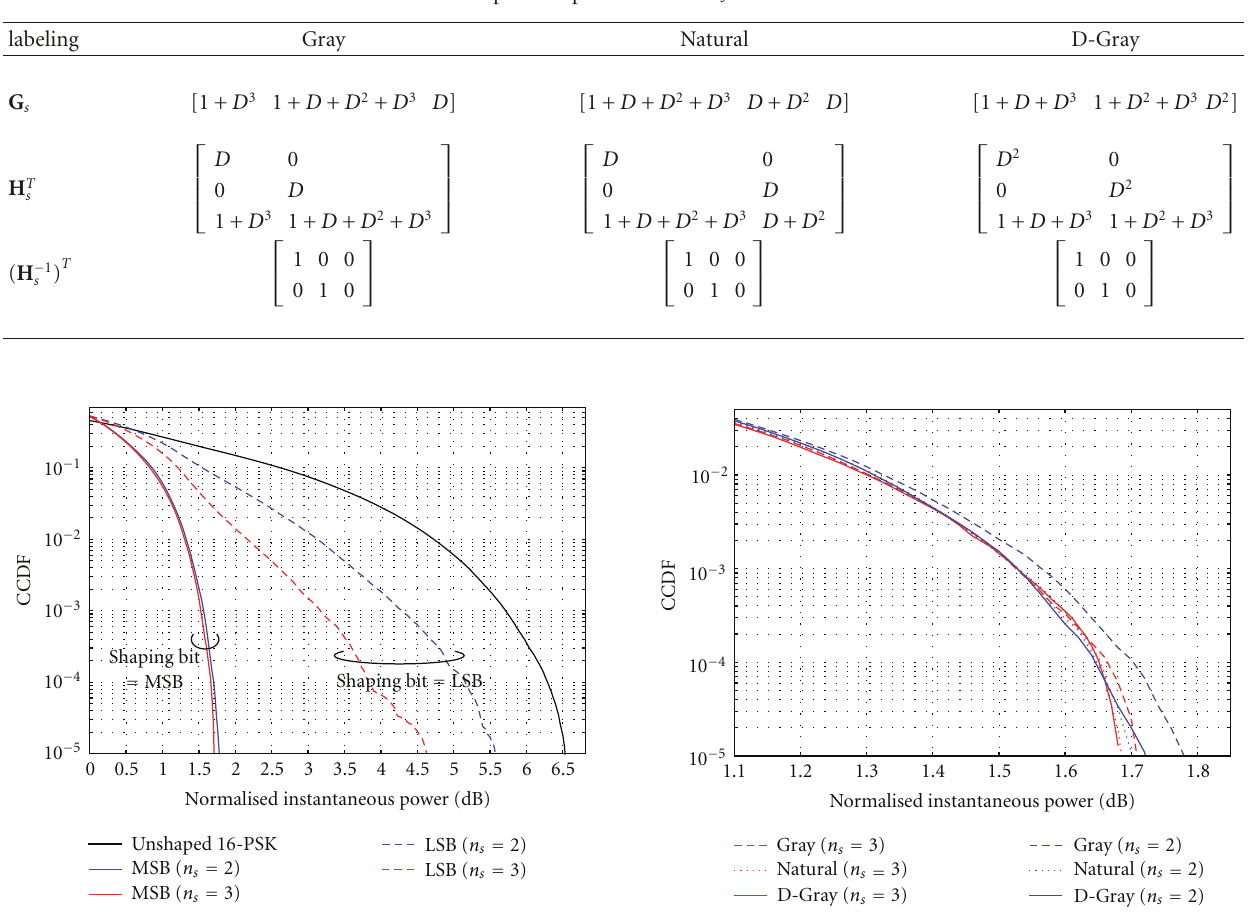
Figure 8: PAPR reduction performance with di ff erent labeling ( n s = 2,